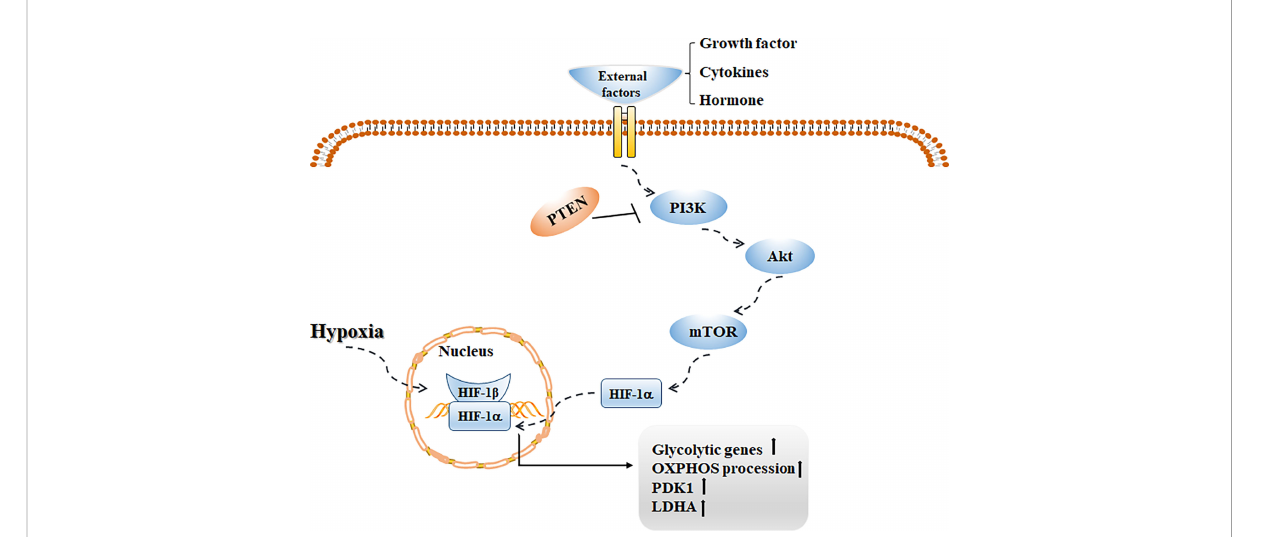
FIGURE 3 With the stimulation of external factors such as growth factor, cytokines and hormone, PI3K/Akt/mTOR signaling pathway is activated, which can promote HIF-1 a transcription activity, increase the transcription of glycolytic genes, up-regulate the levels of PDK1 and LDHA, and then increase glycolysis while inhibit